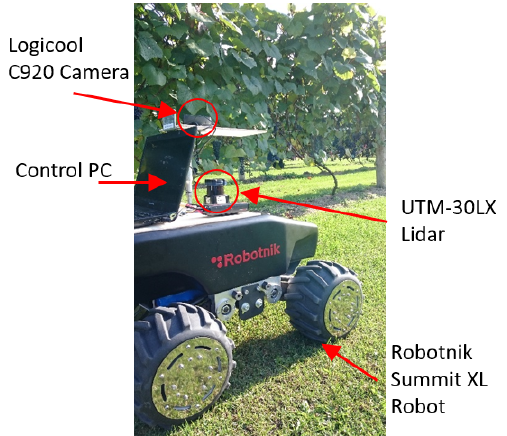
Figure 10. Robotnik’s Summit-XL robot used in the experiment with UTM-30LX Lidar, camera, and control computer.